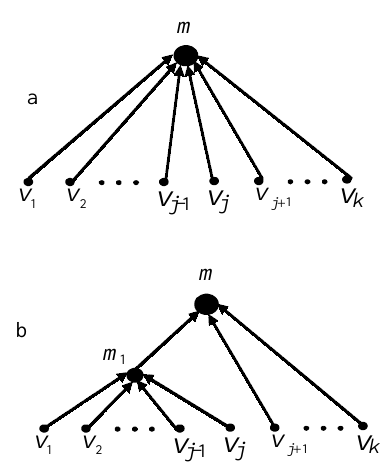
Fig 6. Resubordination for narrowing or widening cost